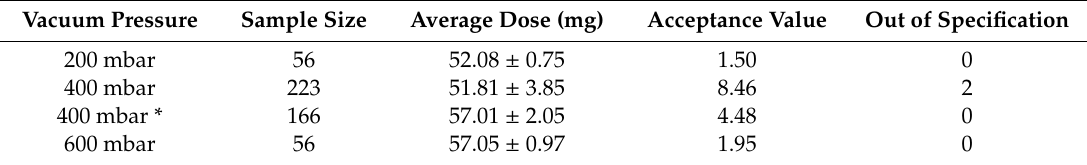
Table 2. The results of the uniformity of dosage units tests after dosing with the Omnidose for the amikacin with 1% L-leucine powder at three different vacuum pressures. Acceptance value (criteria ≤ 15) and the amount of dosage units out of specification are determined according to European